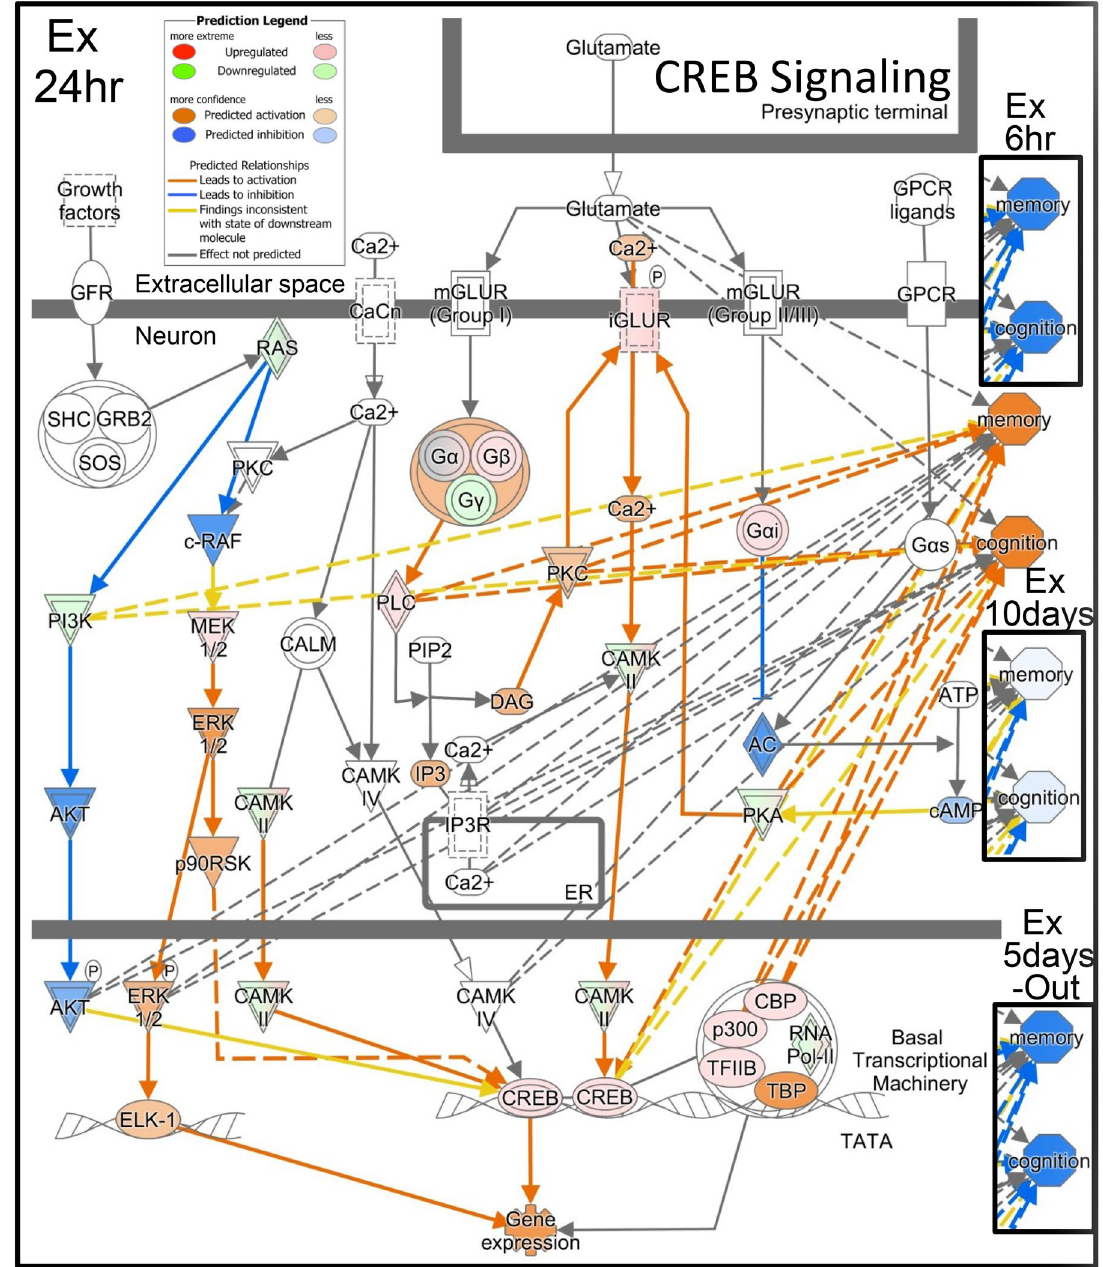
Figure 6. CREB signaling in the Xenopus laevis whole brain after exposure to 24 h of a predation threat from the larval salamander, Hynobius lichenatus . Changes in the memory and cognition pathways were predicted using the Ingenuity pathway analysis and compared to the controls (not exposed to predation) for the expressed genes in each treatment group. The degree of memory and cognition for Ex6hr (exposed to predation for 6 h), Ex10days (exposed to predation for 10 days), and Ex 5 days-Out (exposed to predation for 5 days, and then 5 days without), are shown in the right-hand side